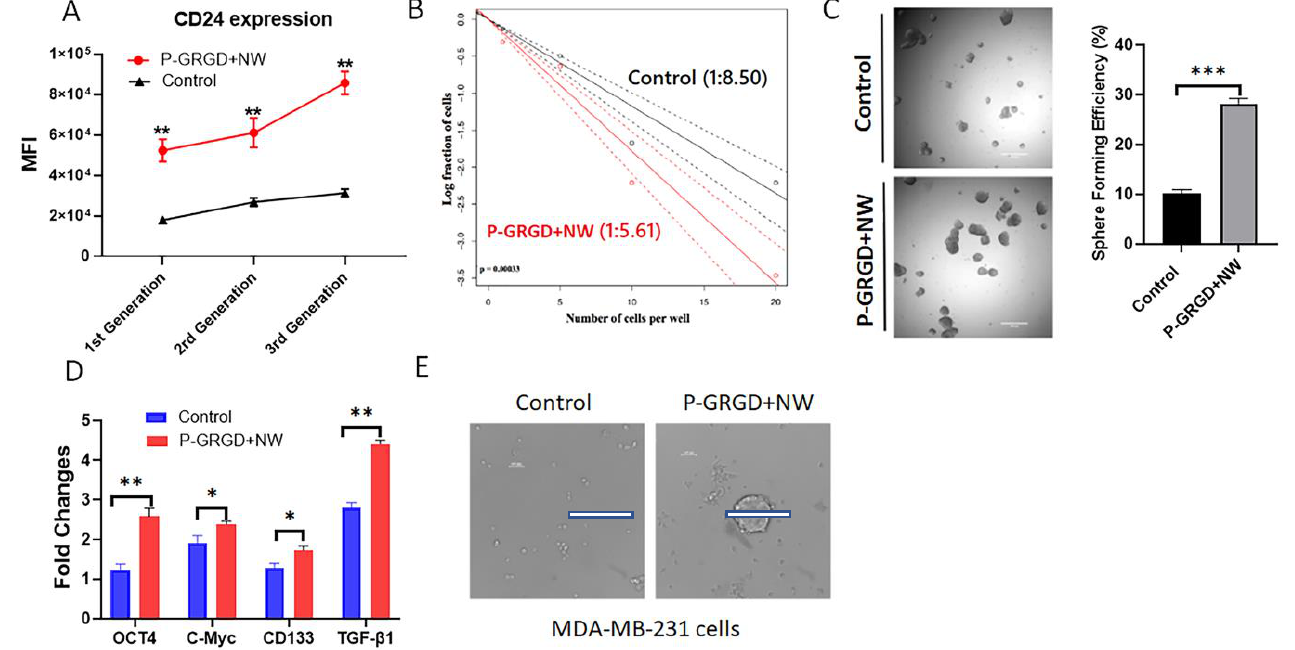
Figure 5. The RGD-ECM system more broadly affects cancer stemness. ( A ) the CD24 expression of CSCs after 3 continuous generations of sphere culture. ( B ) the limiting dilution assay shows that comparing to the control that needs average 8.5 cells to form a sphere, PG+W only needs an average of 5.6 cells to form a sphere. ( C ) the sorted fast-dividing HCT116 cells exhibited a much better sphere forming efficiency after being cultured with PG+W. ( D ) qRT-PCR results of fast-dividing HCT116 cells showing a better ability of expressing signature stem genes after treatment with PG+W. ( E ) MDA-MB-231 breast cancer cells that normally do not form a sphere have formed some typical spheres after being cultured with PG+W. Notes: *: p < 0.05; **: p < 0.01; ***: p < 0.001 ( n = 3). The scale bars in ( C , E ) indicate 500 µm.